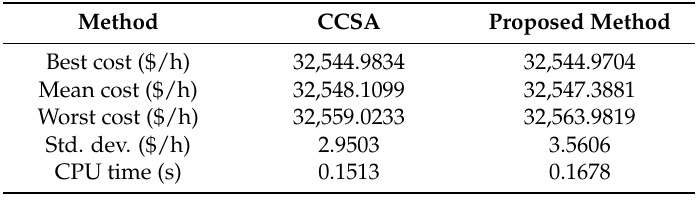
Table 4. The obtained results for the CCSA and proposed method in case 2.